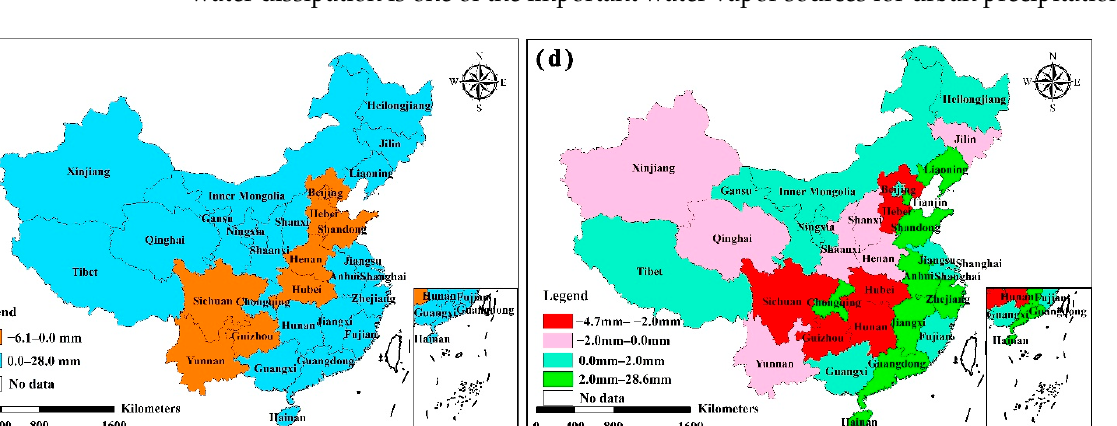
Figure 7. Precipitation changes prior to (1960–1969) and following (2010–2019) urbanization for ( a ) the whole year, ( b ) summer, and ( c ) winter. Changes to the rain island effect for ( d ) the whole year, ( e ) summer, and ( f ) winter following urbanization. 4. Discussion It should be noted that although urban precipitation changes are influenced by ur- banization, they are also related to periodic precipitation fluctuations caused by climate change. To eliminate the impact of climate change, we compared and analyzed the differ- ences in the urban rain island effect between urban and suburban areas from 1960 to 1969 and 2010 to 2019 (Figure 7d), and the results were consistent with the spatial distribution of urban precipitation changes before and after urbanization (Figure 7a). The rain island intensity along the southeast coast and northwest inland region has increased following urbanization. The rain island’s intensity along the southeast coast greatly increased (>2 mm), with a maximum increase of 28.6 mm occurring in Hainan Province. Therefore, the